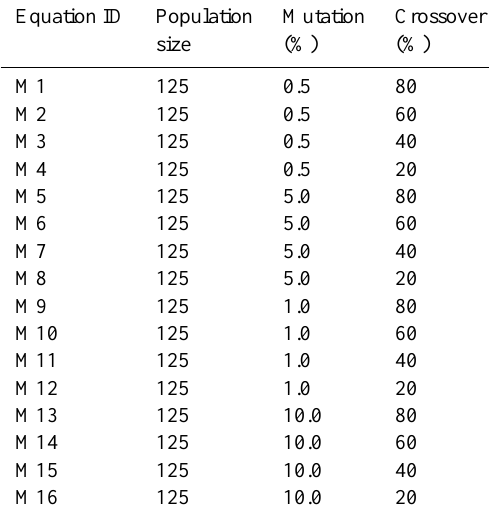
Table 2. GA parameters. Table 3. Minimum, maximum and average values of parameters used in dataset.